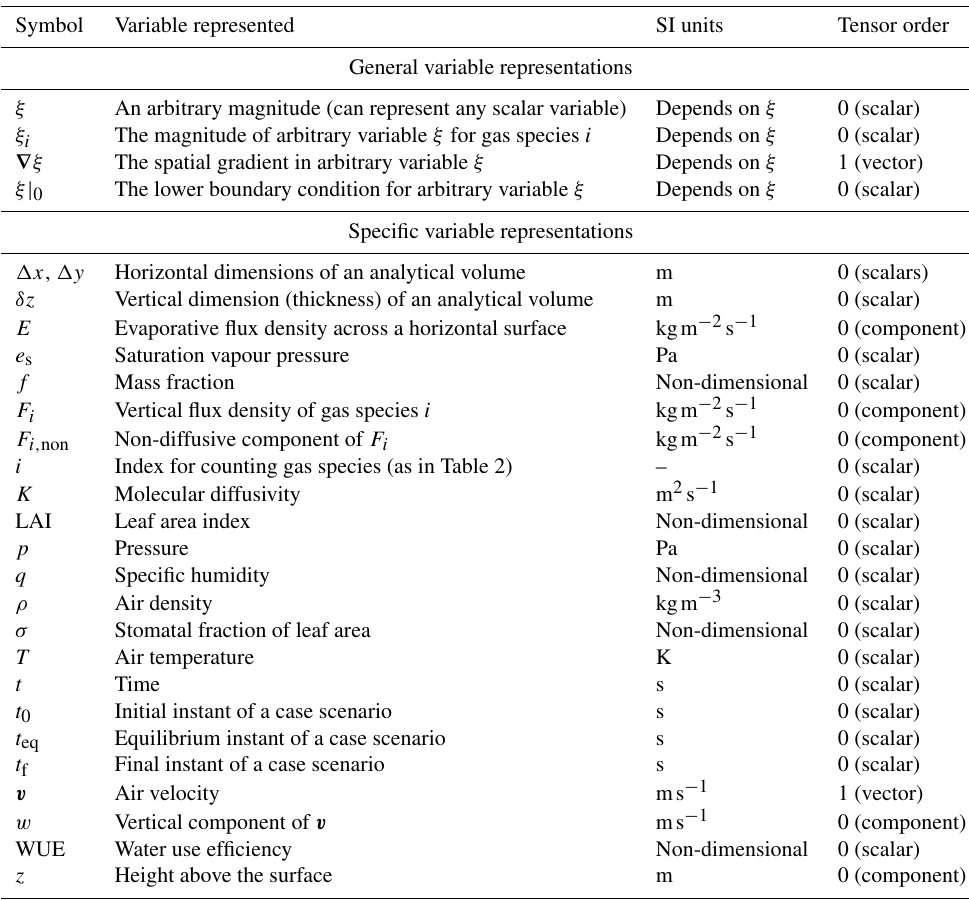
Equilibrium instant of a case scenario Air velocity Vertical component of v ms − 1 WUE Water use efficiency Non-dimensional 0 (scalar) z Height above the surface m 0